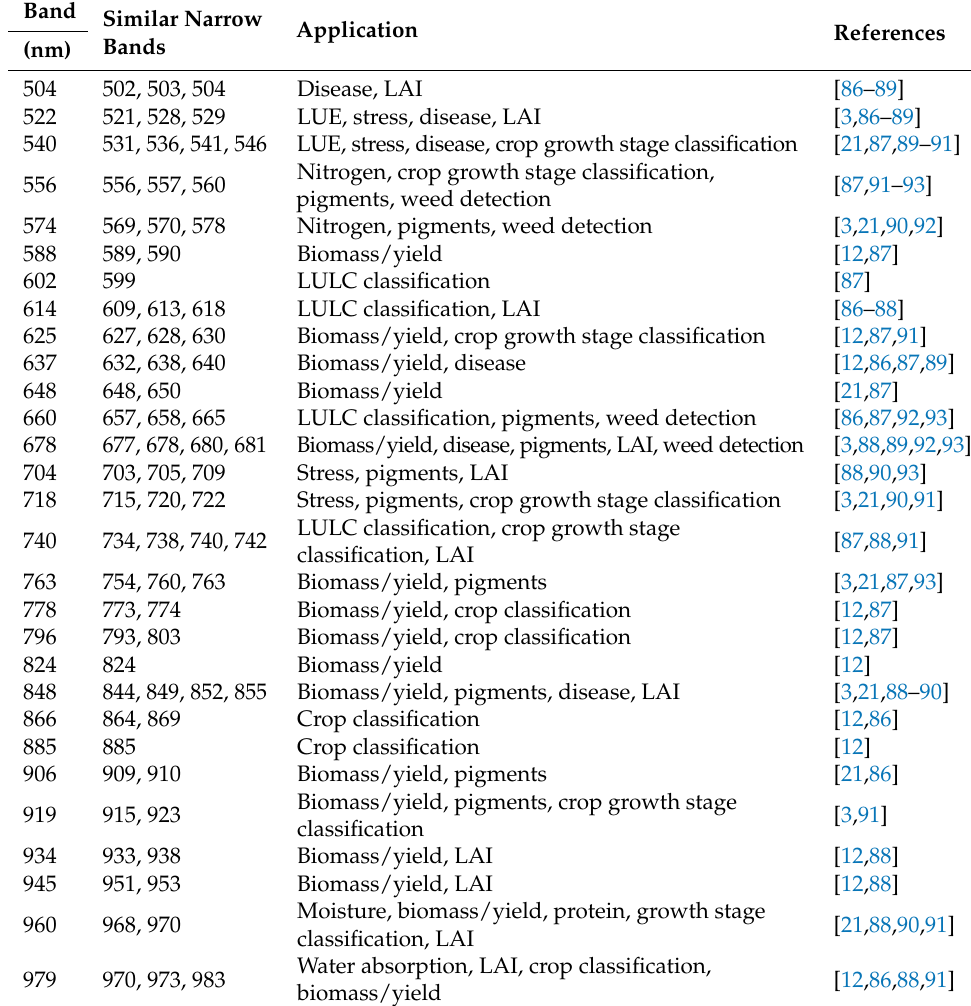
Table 4. Most important DESIS bands. The 29 most important bands from DESIS data for vegeta- tion classification, similar narrow bands selected by other researchers from multiple sensors, and applications for which the bands were used. LUE = Light-use efficiency, LAI = Leaf Area Index, LULC = Land use and land